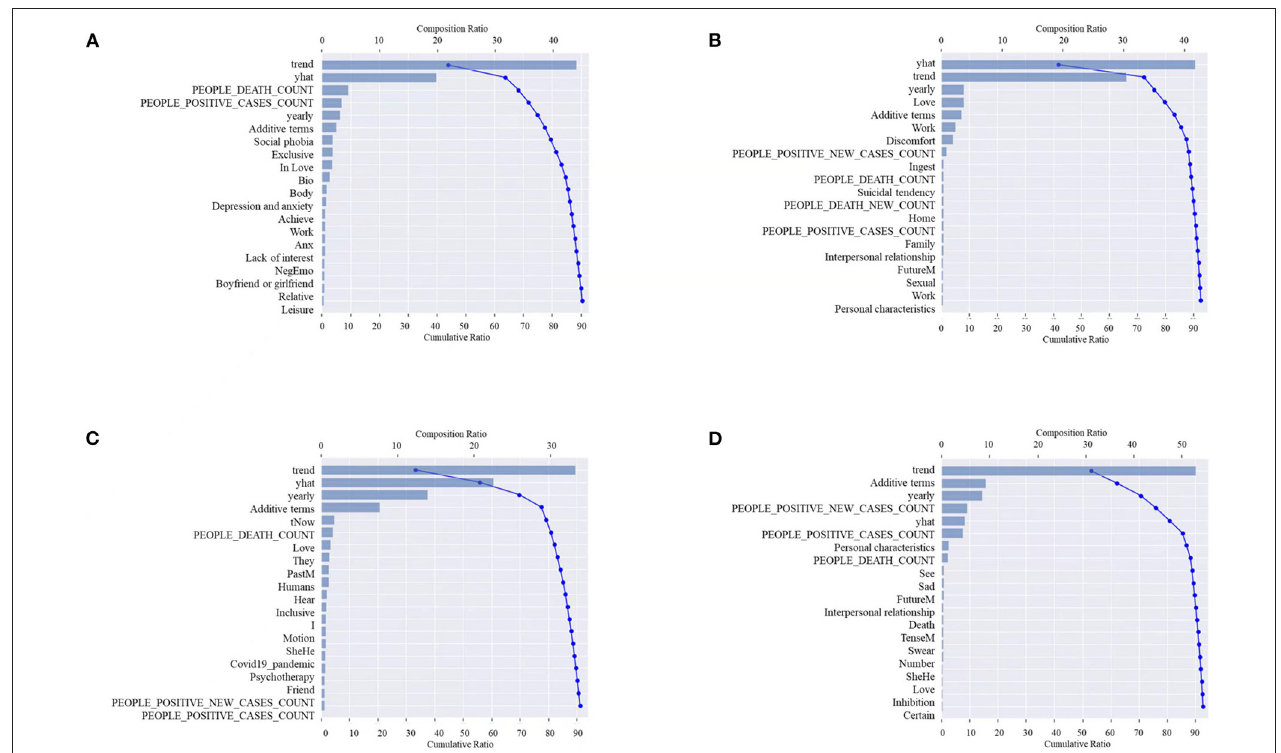
FIGURE 3 | Top-20 features of predictions with lagging one (A) , three (B) , seven (C) , and 14 days (D)